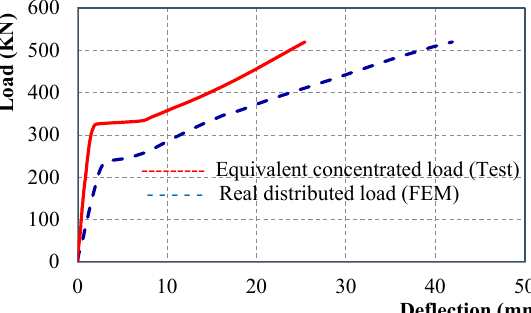
Figure 31. Modeling of uniform load.